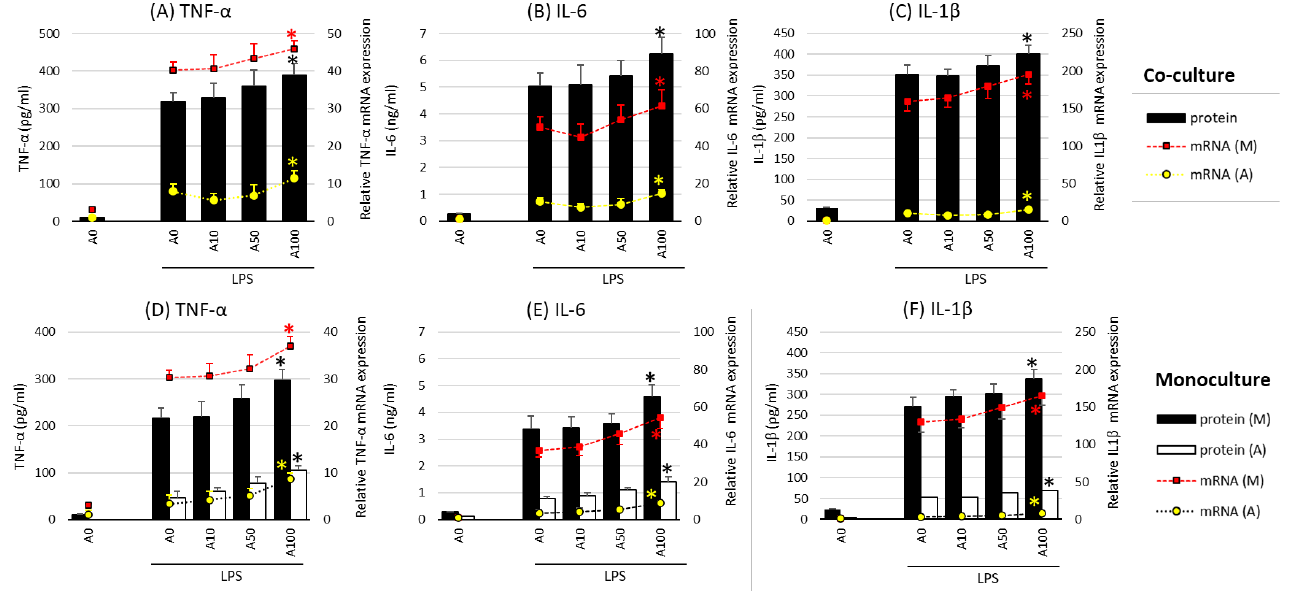
Figure 2. Effects of asprosin on lipopolysaccharide (LPS; 100 ng/mL)-induced cytokine mRNA expression and release: tumor necrosis factor-alpha (TNF- α ) ( A ), interleukin-6 (IL-6) ( B ), and interleukin-1 beta (IL-1 β ) ( C ) in adipocyte–macrophage cocultures (upper panel) and adipocyte and macrophage monocultures (lower panel) for TNF- α ( D ), IL-6 ( E ), and IL-1 β ( F )on the 21st day of differentiation. The results are expressed as mean + standard deviation (SD) from five independent experiments. Statistical significance ( p < 0.05) was determined by the Duncan t -test. The asterisk (*) above the bar denotes statistically significant differences in protein or mRNA levels, calculated relative to the A0 + LPS control group. Cells: (M) macrophages; (A)